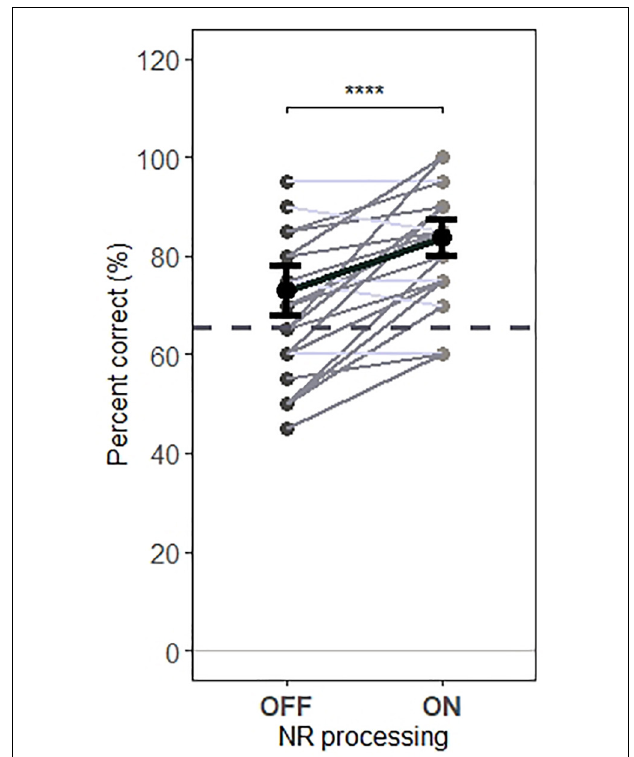
FIGURE 8 | Behavioral performance for each condition. The NR scheme improves the behavioral performance. A significant main effect of NR scheme on behavioral performance was observed, indicating increased participants’ accuracy in responding to questions about target speech, when NR scheme was active. Gray dots indicate trial-averaged individual behavioral performance results, whereas black dots and error bars show the group (grand-average ± 1 between subject SEM) behavioral performance results. Each gray dot represents the behavioral performance results for a single participant, each horizontal line in gray denotes single participant (dark gray denotes increased accuracy and light gray denotes reduced accuracy when activating NR scheme) and each horizontal line in black depict prediction of linear mixed model. The dashed horizontal line in gray the behavioral performance level at which behavioral results are significantly greater than chance (65.625 %) based on a binomial test at the 5% significance level. The asterisk indicates significant differences (* p = 0 . 05, ** p = 0.01, *** p = 0.005, and **** p =